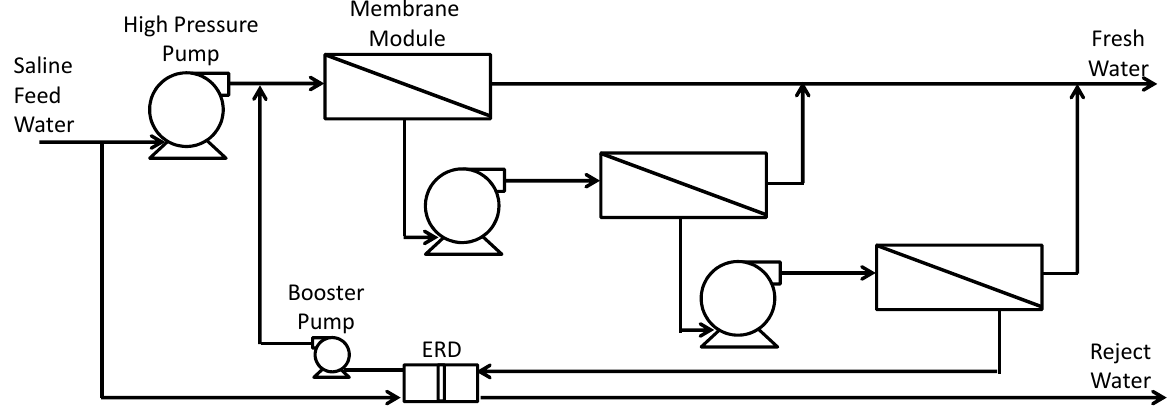
Figure 7. Multi-stages system with work exchanger type